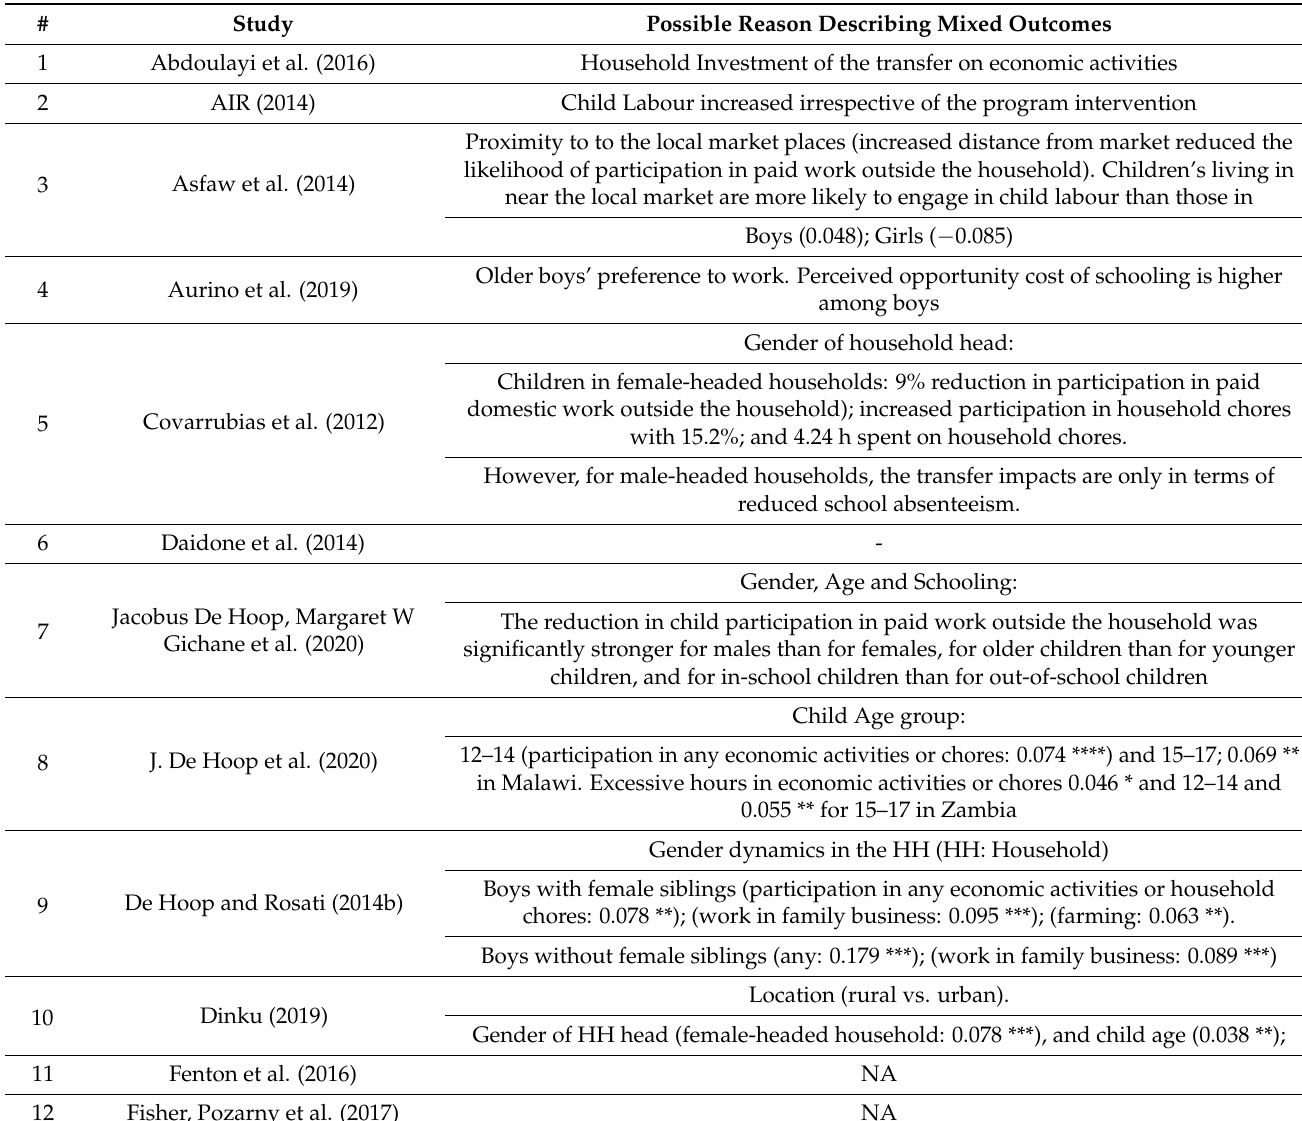
Table 4. Child-specific and household factors explaining mixed outcome on child labour and/or